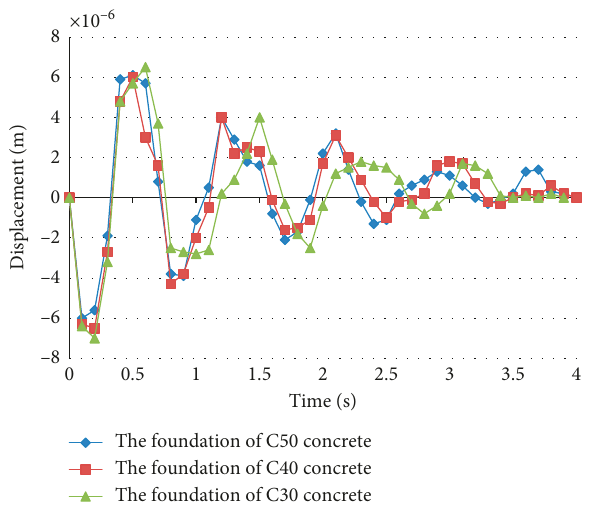
Figure 9: Effect of concrete type on system dynamic characteristics.